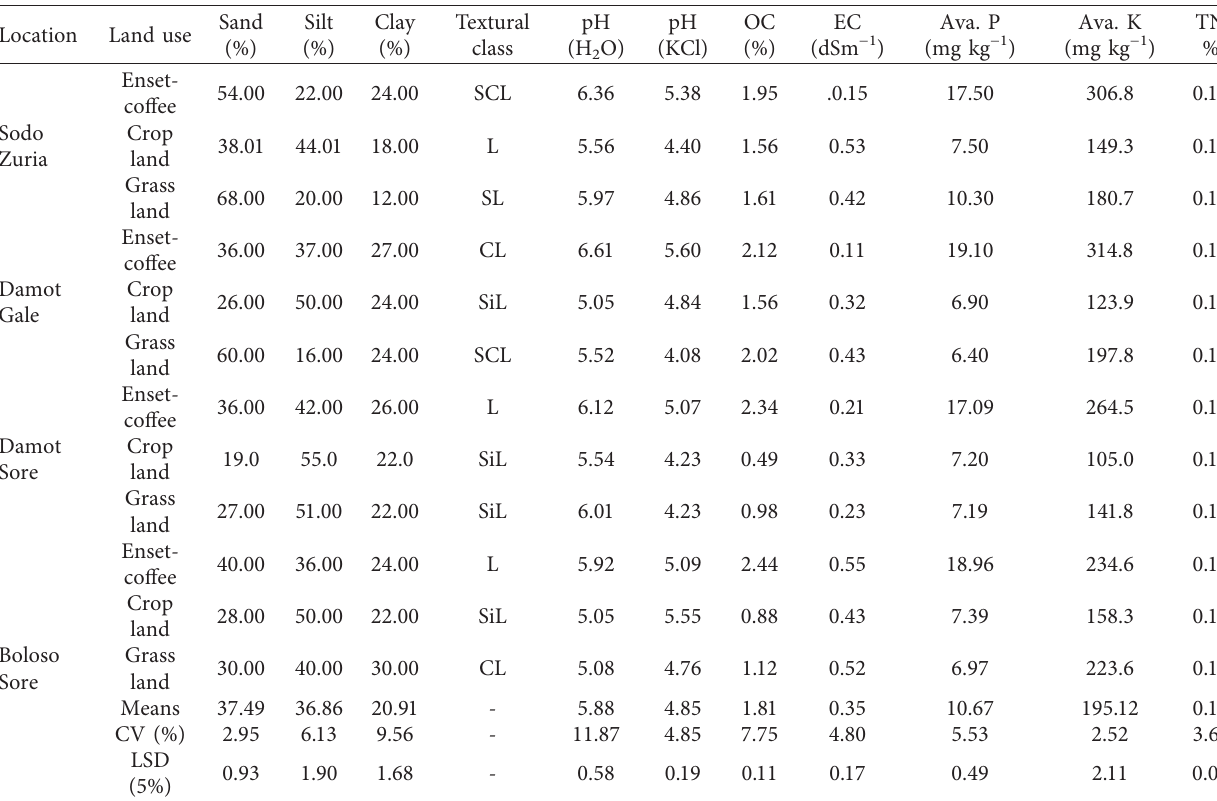
Table 1: Selected physical and chemical properties of the soils as influenced by land uses and locations.